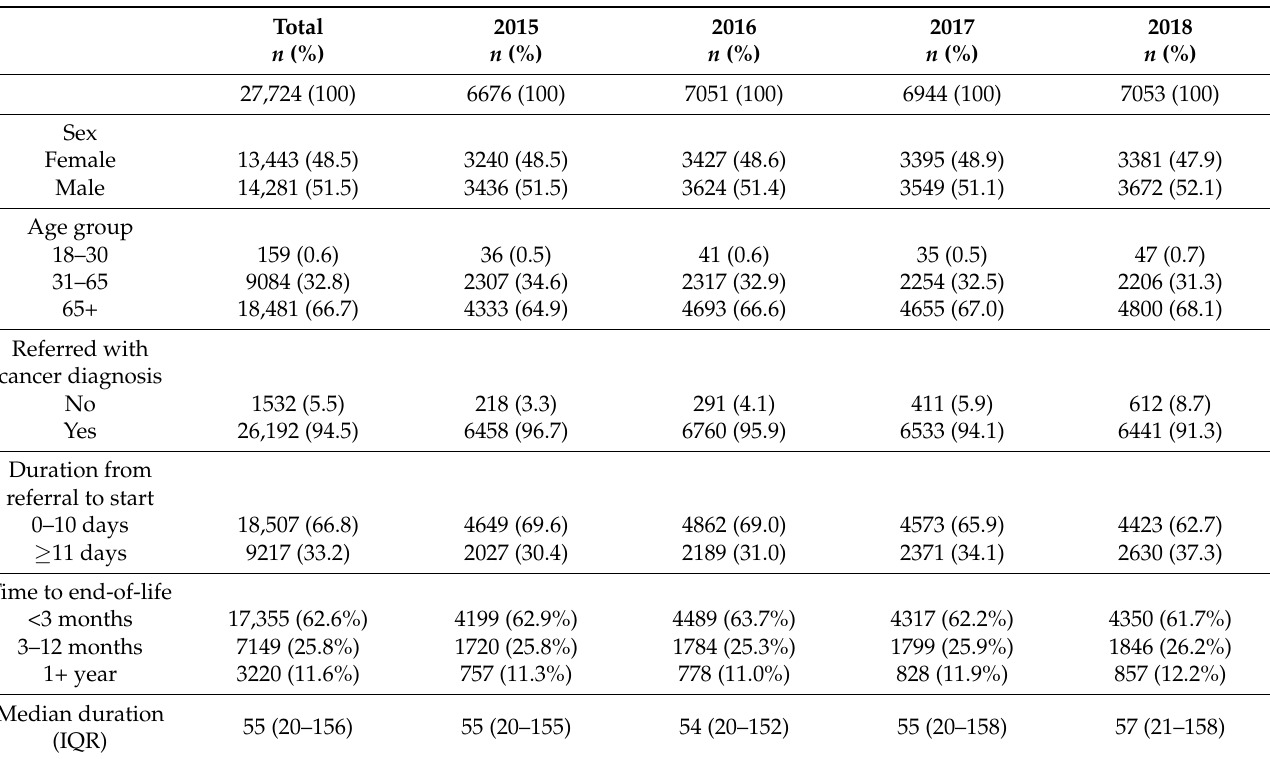
Table 1. Demographics of patients in specialised palliative care